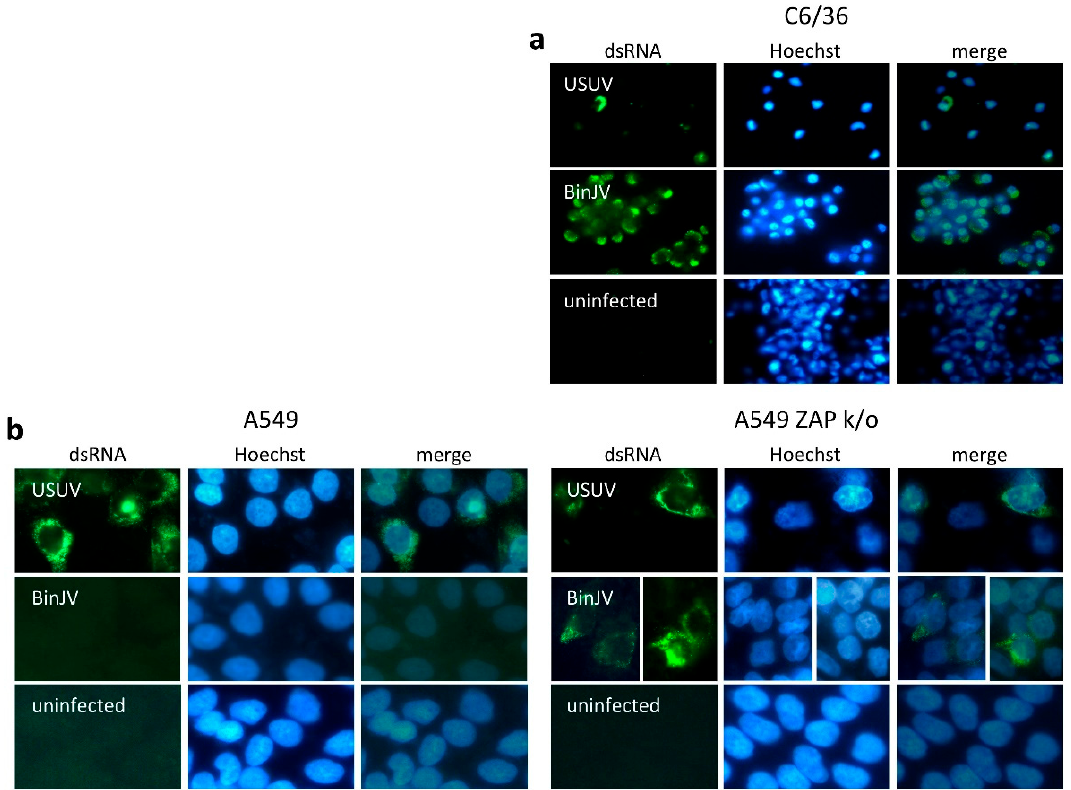
Figure 3. BinJV dsRNA replication intermediates in human ZAP knockout cells. ( a ) C6/36 mosquito cells and ( b ) A549 and ZAP knockout thereof infected with VIF USUV or ISF BinJV. Samples were stained for viral dsRNA (green) and nuclei stained with Hoechst 33342 (blue). Micrographs were taken using a Zeiss Axio Observer Z1m inverted microscope with an LD Plan-Neofluar 40 × /0.6 Ph2 korr objective and are representative images from one of three biological repeat experiments, see Figure S2 for additional images.